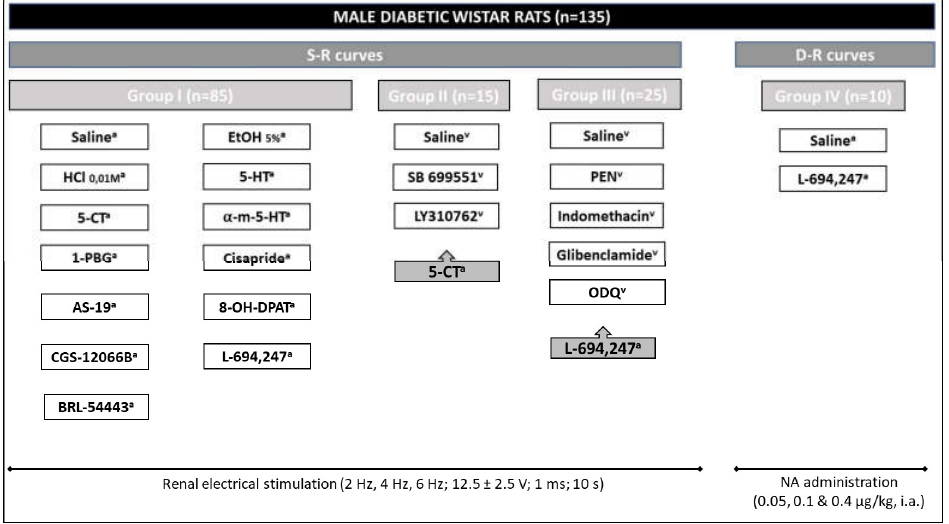
Figure 8. Scheme of experimental protocols, showing the number of animals used. Experimental protocols showing the two main sets of diabetic animals and the different groups used in these experiments, in which renal vasopressor responses are obtained by renal nerve sympathetic stimulation (S-R curves) or i.a. bolus of noradrenaline (NA) (D-R curves). a i.a. administration; v i.v.